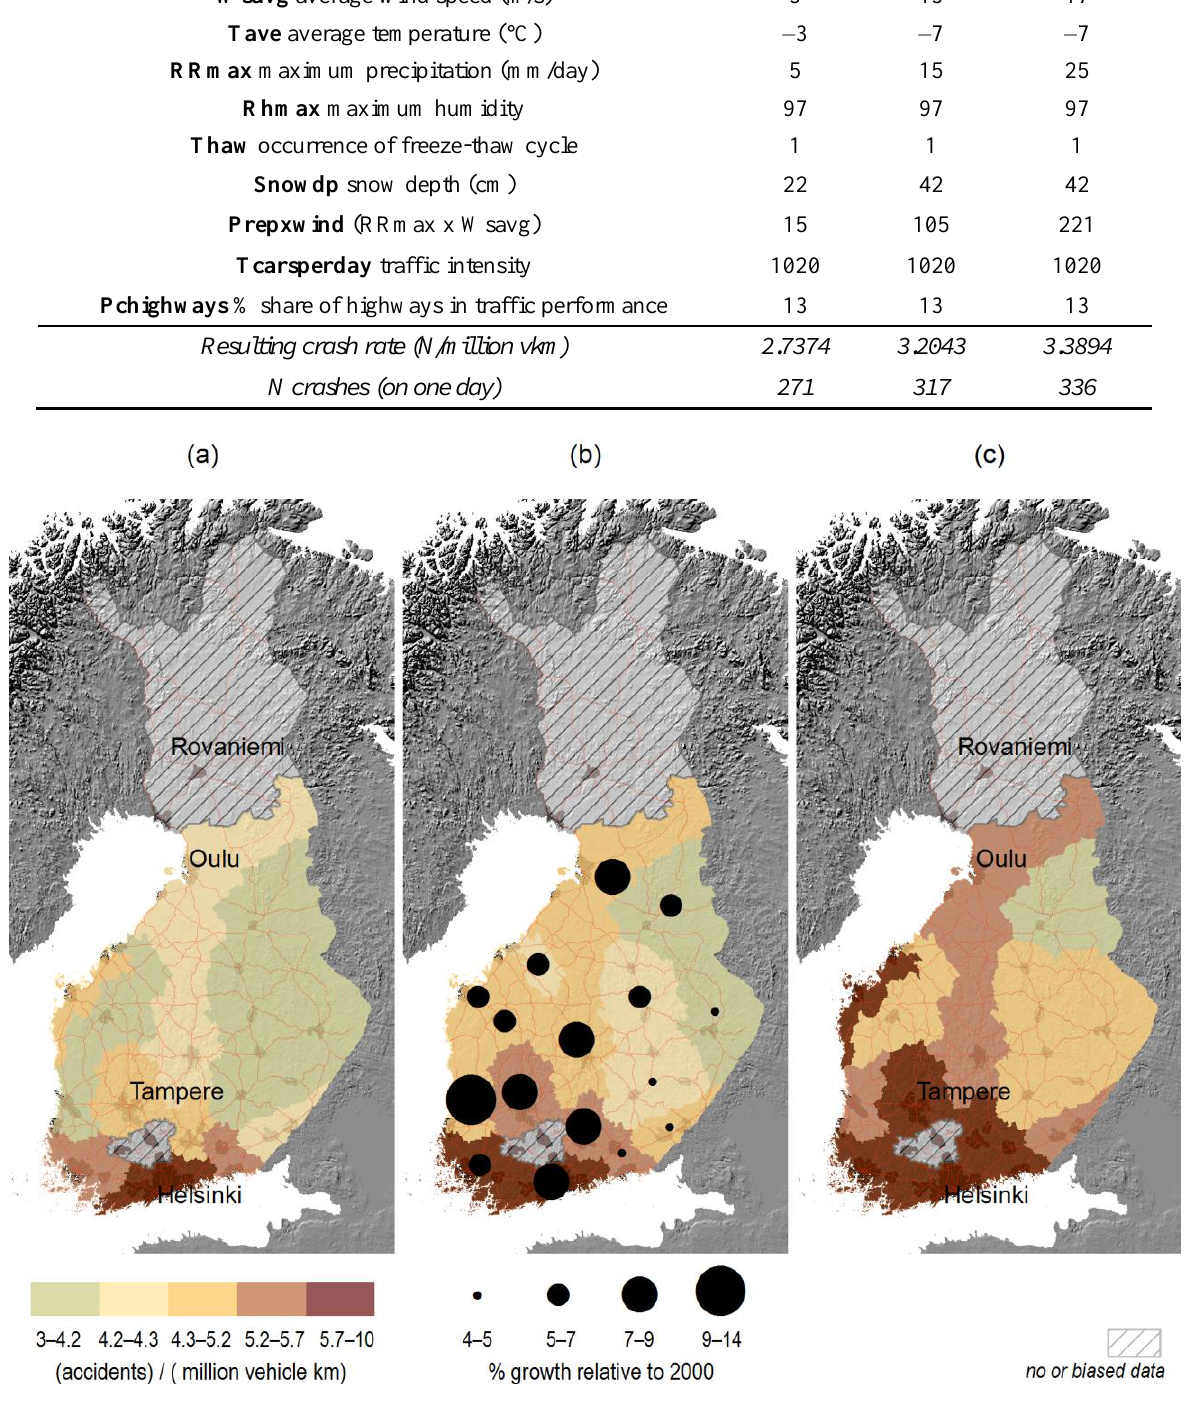
Figure 6. ( a ) Road vehicle crash rates (per million vehicle kilometers) in normal weather conditions in 2000 per Finnish province; ( b ) Crash rates in normal weather conditions in 2010, and growth from 2000; ( c ) Crash rates in very bad weather conditions in 2010. The colour scale divisions are common for all